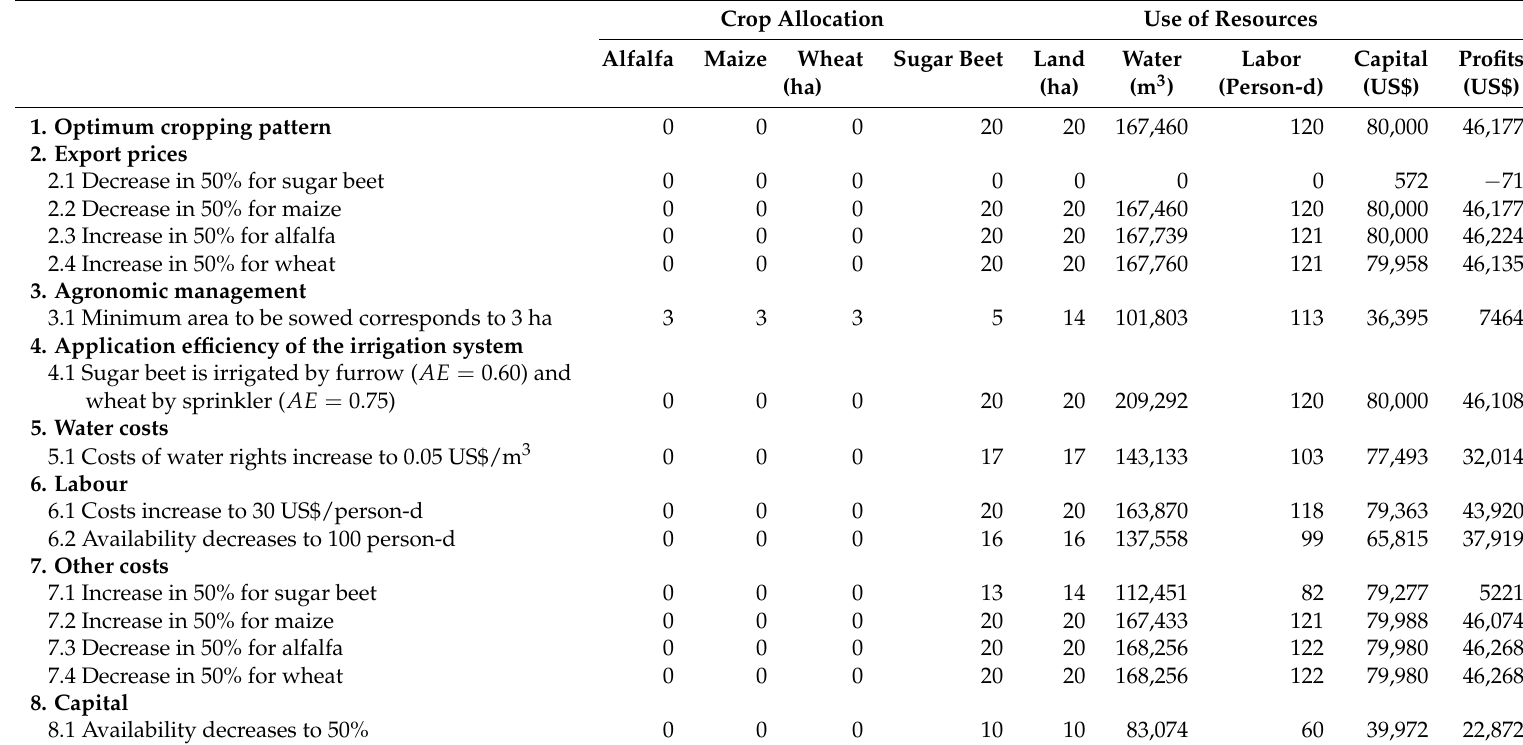
Table 6. Sensitivity analysis for scenario 6, situation